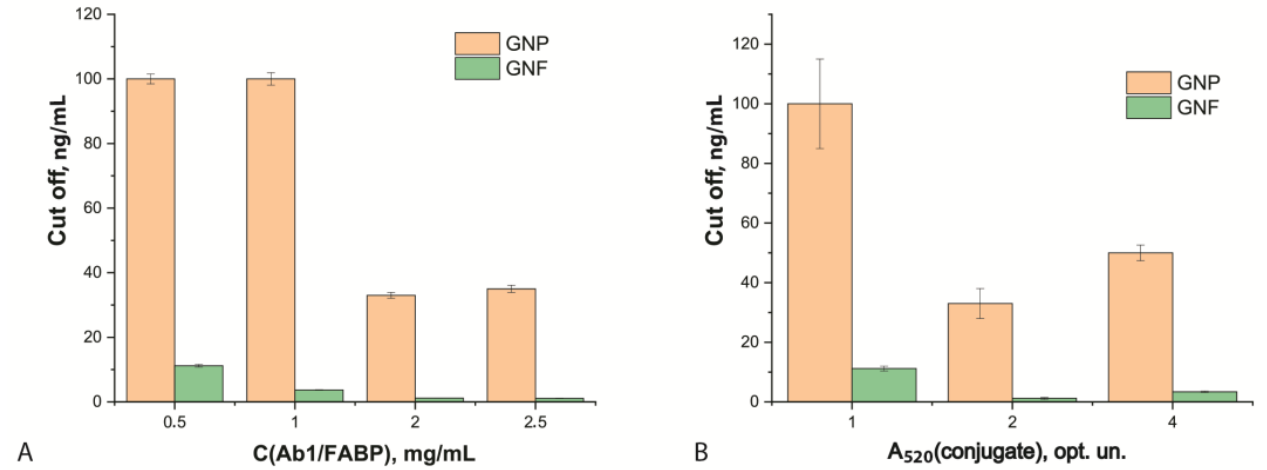
Figure 6. Choice of ICA conditions for test systems with GNPs and GNFs. Dependence of cut off values on the concentration of F5/FABP applied in the analytical zone ( A ) and on the optical density of the used antibody-nanoparticles conjugates solutions ( B ) (n = 5).